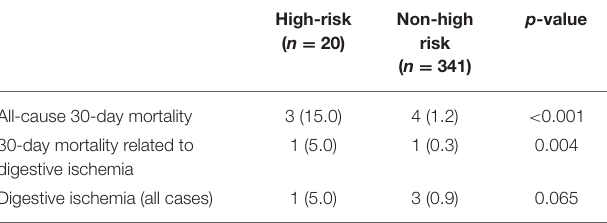
TABLE 4 | Postoperative endpoints of patients at high-risk for mesenteric ischemia, vs. patients non at high-risk.